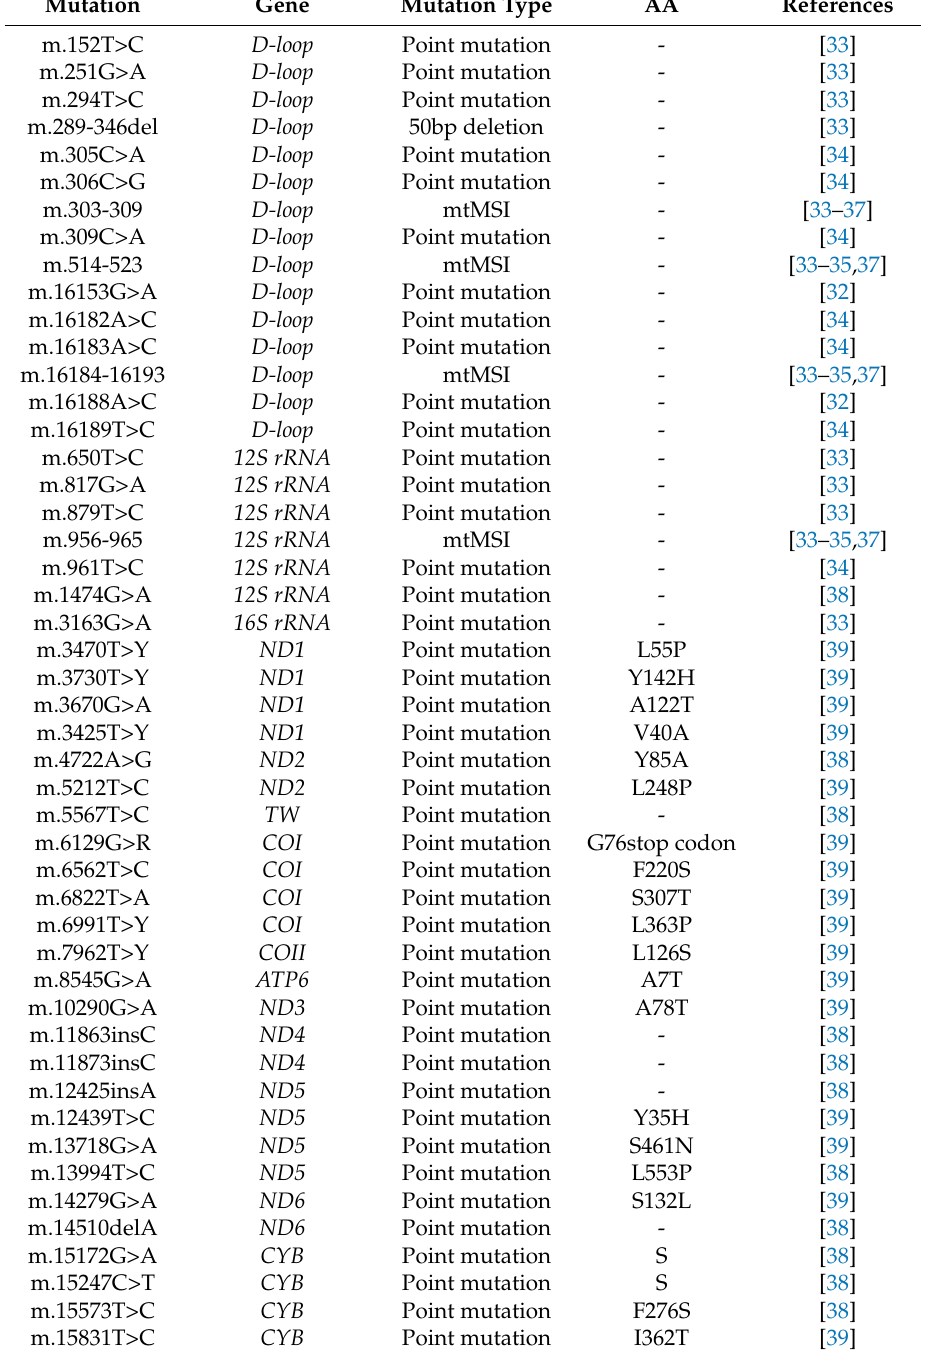
Table 2. Somatic mitochondrial DNA mutations in endometrial